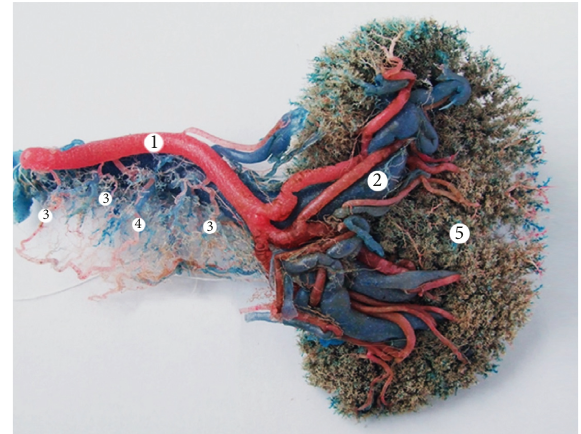
Figure 7: Type II vascular supply of the pancreas (corrosion cast). 1: splenic artery; 2: splenic vein; 3: short branches of the splenic artery; 4: transverse pancreatic artery; and 5: spleen.